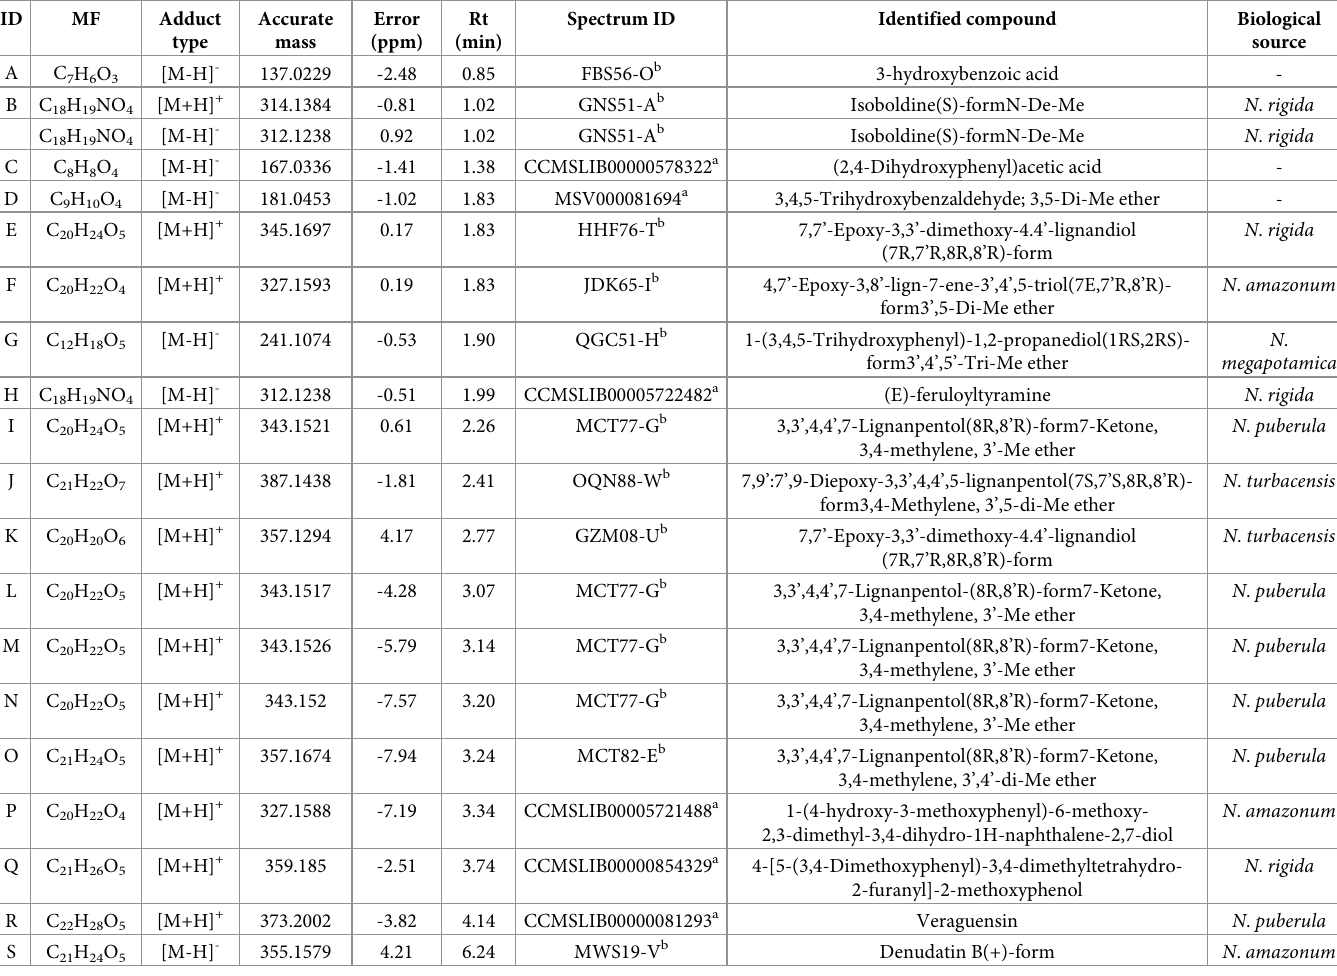
Table 1. Dereplicated compounds (ESI—positive and negative ionization modes) from CH 2 Cl 2 phases of EtOH extracts obtained from Nectandra oppositifolia leaves and